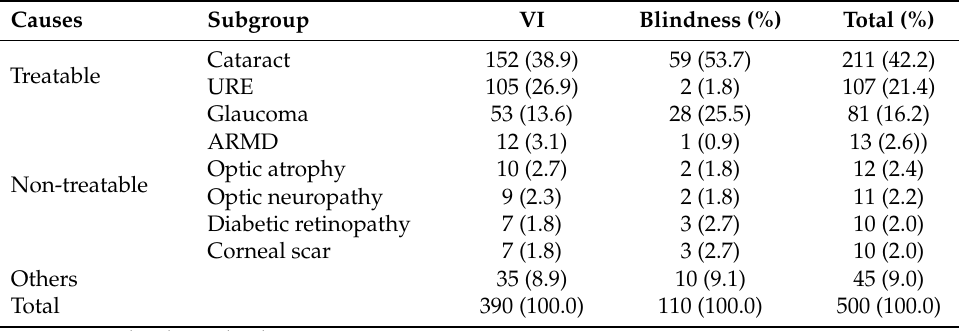
Table 4. Causes of visual impairment and blindness.